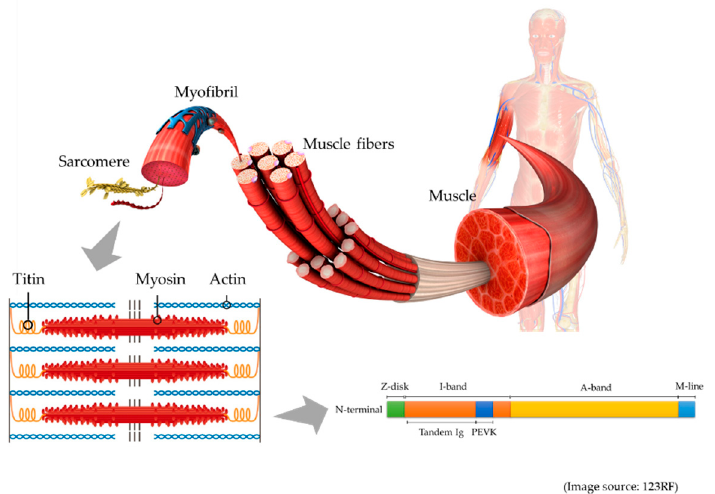
Figure 1. This is a schematic illustration of titin in the muscle. Muscle comprises of muscle fibers, myofibrils, and the smallest units, known as sarcomeres. In the sarcomere (lower left), titin connects actin-containing thin filaments and myosin-containing thick filaments. In the schematic illustration of titin structure (lower right), titin is composed of Z-disk, I-band, A-band, and M-line regions, and the I-band includes tandem Ig and PEVK (Pro-Glu-Val-Lys) domains. different fragments are measurable. In serum, the metalloproteinase (MMP) 2-cleaved